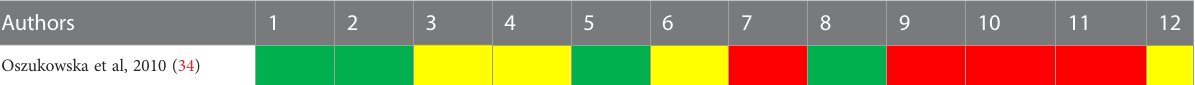
TABLE 6 Critical Appraisal Skills Programme Case-Control Study